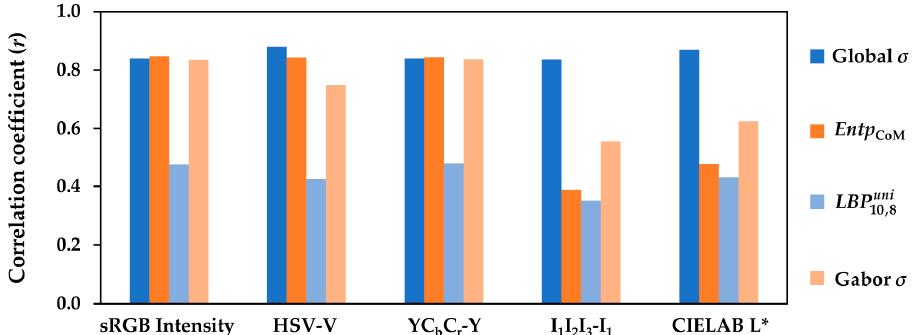
Figure 19. The performance of various texture measures computed for the luminance channel of the textile images in the sRGB, HSV, YC b C r , I 1 I 2 I 3 , and CIELAB color spaces in terms of their correlations with the VRS Cpx of the textiles given by a panel of observers.